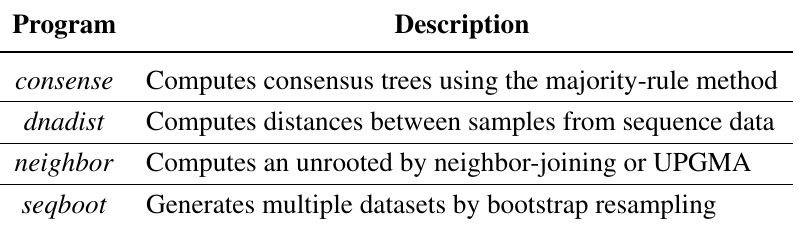
Table 3. Programs from the “Phylip” suite, which are used by the “Pipeline: TreeMail”